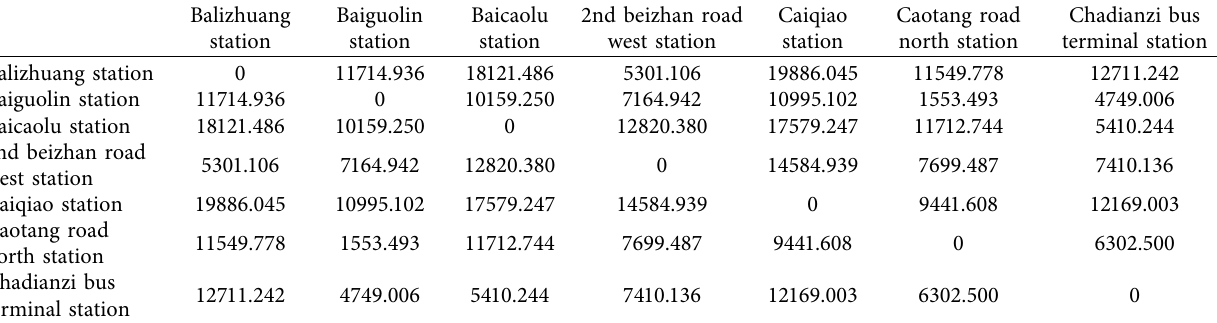
Table 1: Example of the distance matrix (unit: meter).